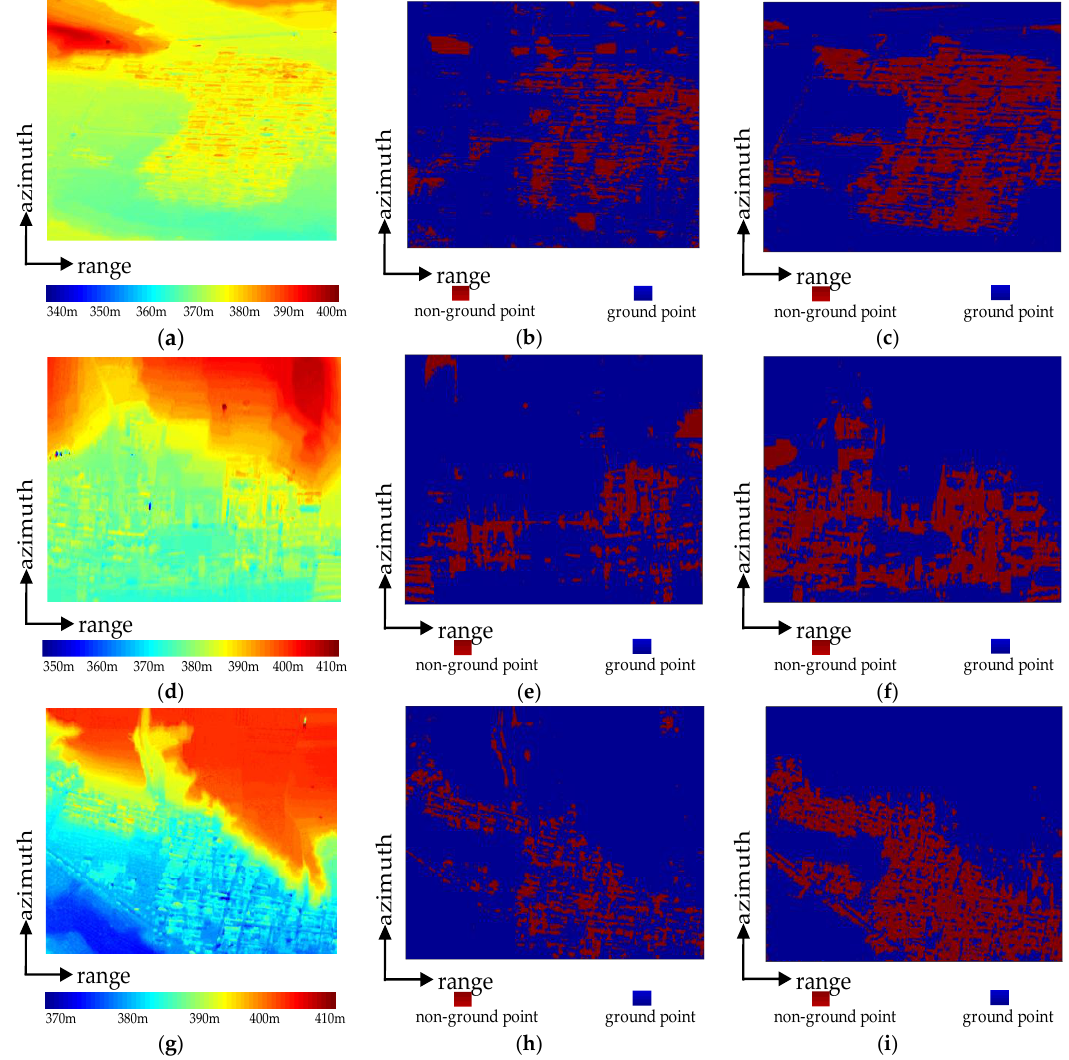
Figure 9. Hierarchical surface fitting results. ( a ), ( d ), and ( g ) are the InSAR digital surface model (DSM); ( b ), ( e ), and ( h ) are the first surface fitting results; and ( c ), ( f ), and ( i ) are the third surface fitting